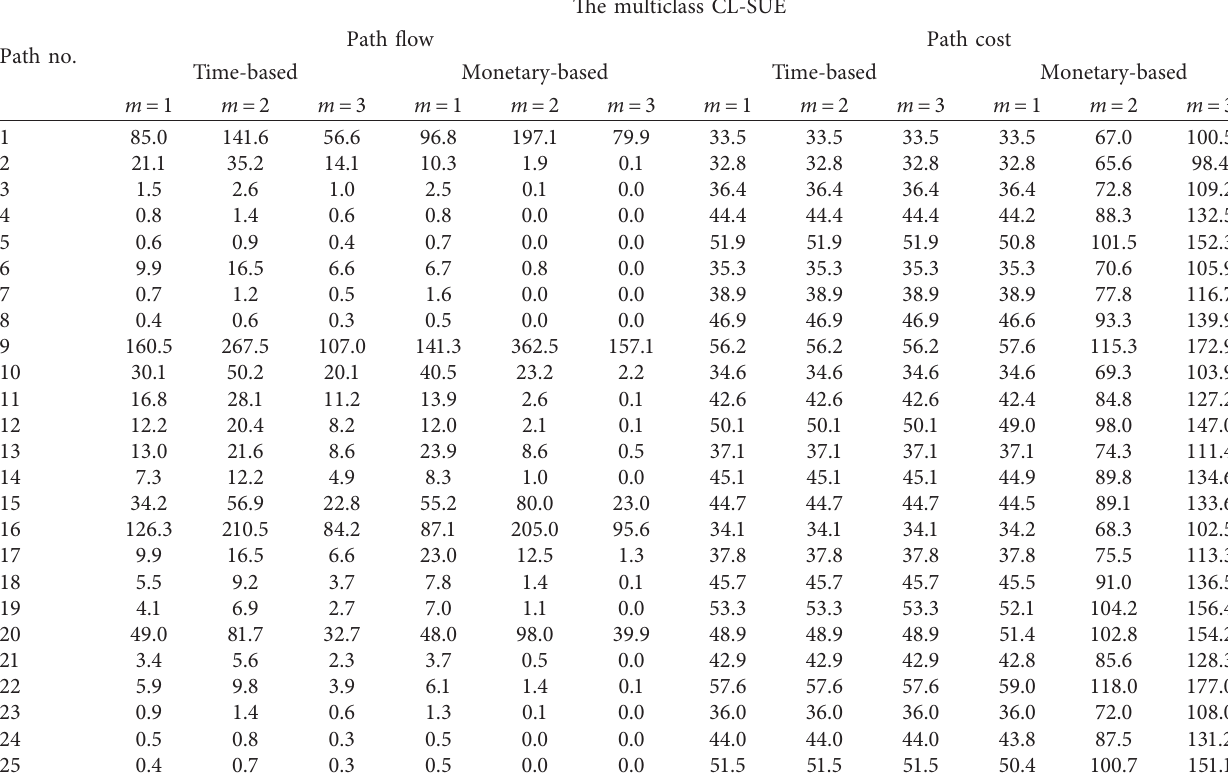
Table 6: Path results of the multiclass CL-SUE model.